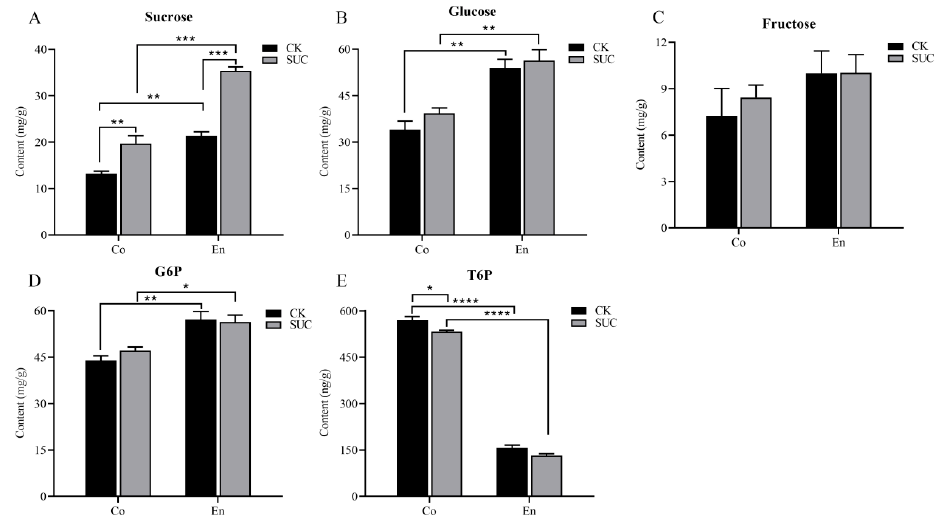
Figure 1. Effect of sucrose treatment on the contents of ( A ) sucrose, ( B ) glucose, ( C ) fructose, ( D ) G6P, and ( E ) T6P in seed coat (Co) and endosperm (En) of P. ostii at 50 days after flowering. The black bar represents the control group, while the grey bar represents the sucrose-treated group. Each value represents the mean ± SD of three replicates ( n = 3). Asterisks indicate significant differences between the sucrose treatment group and the controls: * p < 0.05; ** p < 0.01; *** p < 0.001; **** p < 0.0001 (one-way ANOVA).